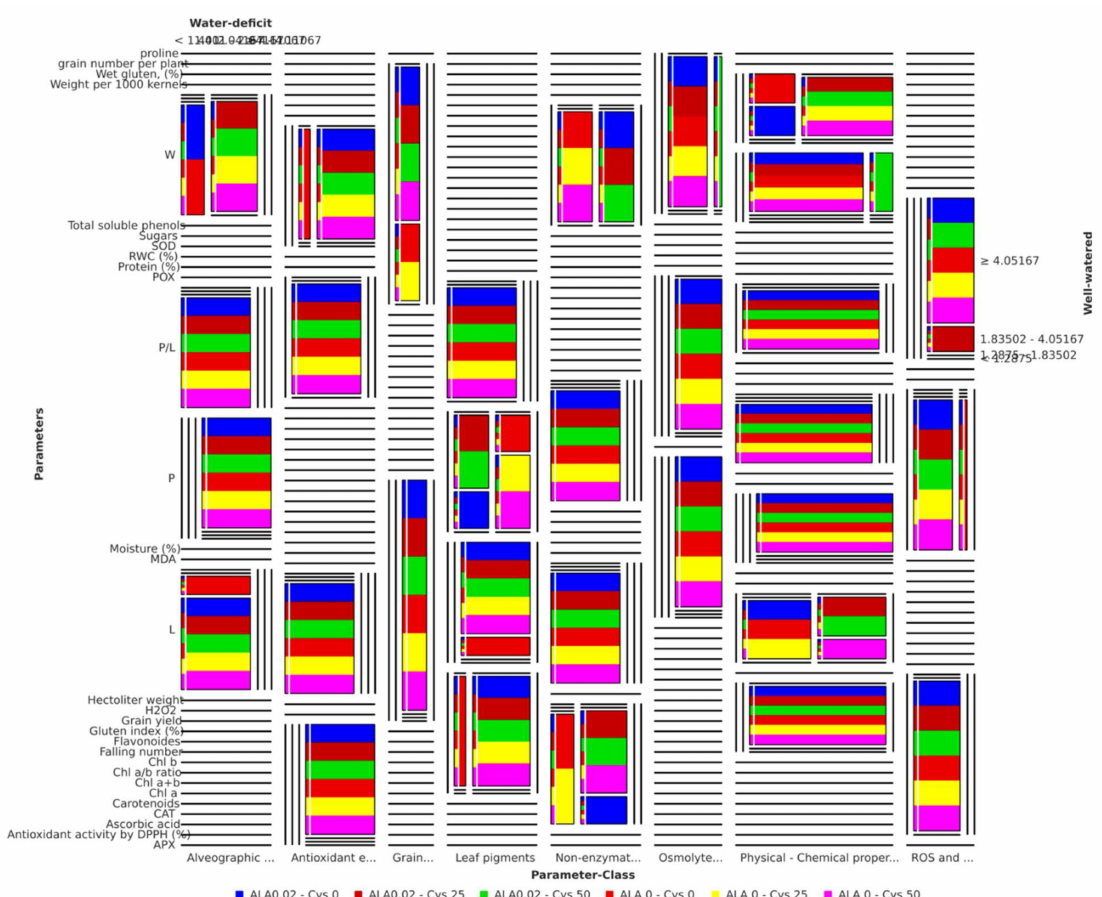
Figure 11. Mosaic plot representing a contingency table of the water deficit and well watered treatments variants versus the 31 parameters included in the study. The vertical size of the cells is proportional to the number of variants found in the respective parameter; the horizontal size of the cells is proportional to the effect level of the six “seed soaking and foliar application” types for each parameter under each parameter-class. The colors of the variants (seed soaking and foliar application) are indicated at the bottom of the Mosaic plot in colored squares similar to the respective bars in the Mosaic plot. Variants were not found at all possible locations of each parameter-class, which causes the reduction of several bars to dashed lines drawn as place holders and indicating that at the particular location no variant has been found in the